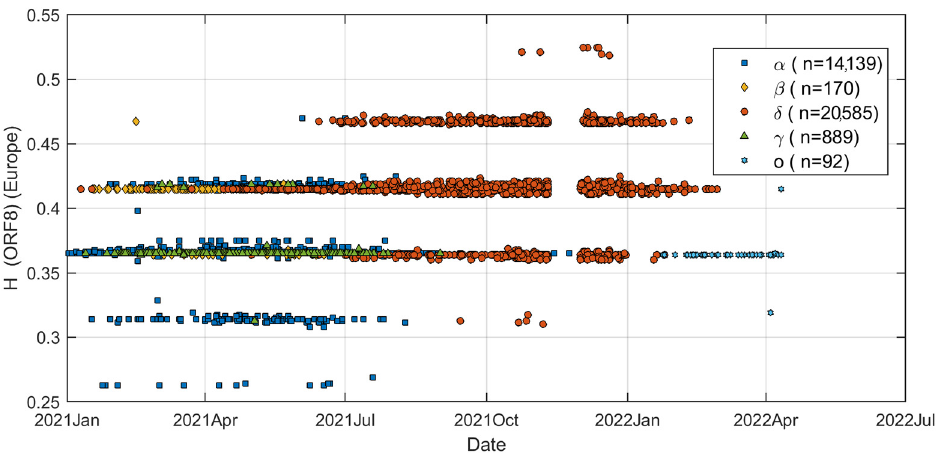
Figure 4. The average HGS value of ORF 8 gene in Delta variant is significantly higher than that in other variants. The Delta variant appeared between 2021 and 2022. The dataset contains 35,875 genomes with geolocation of Europe.